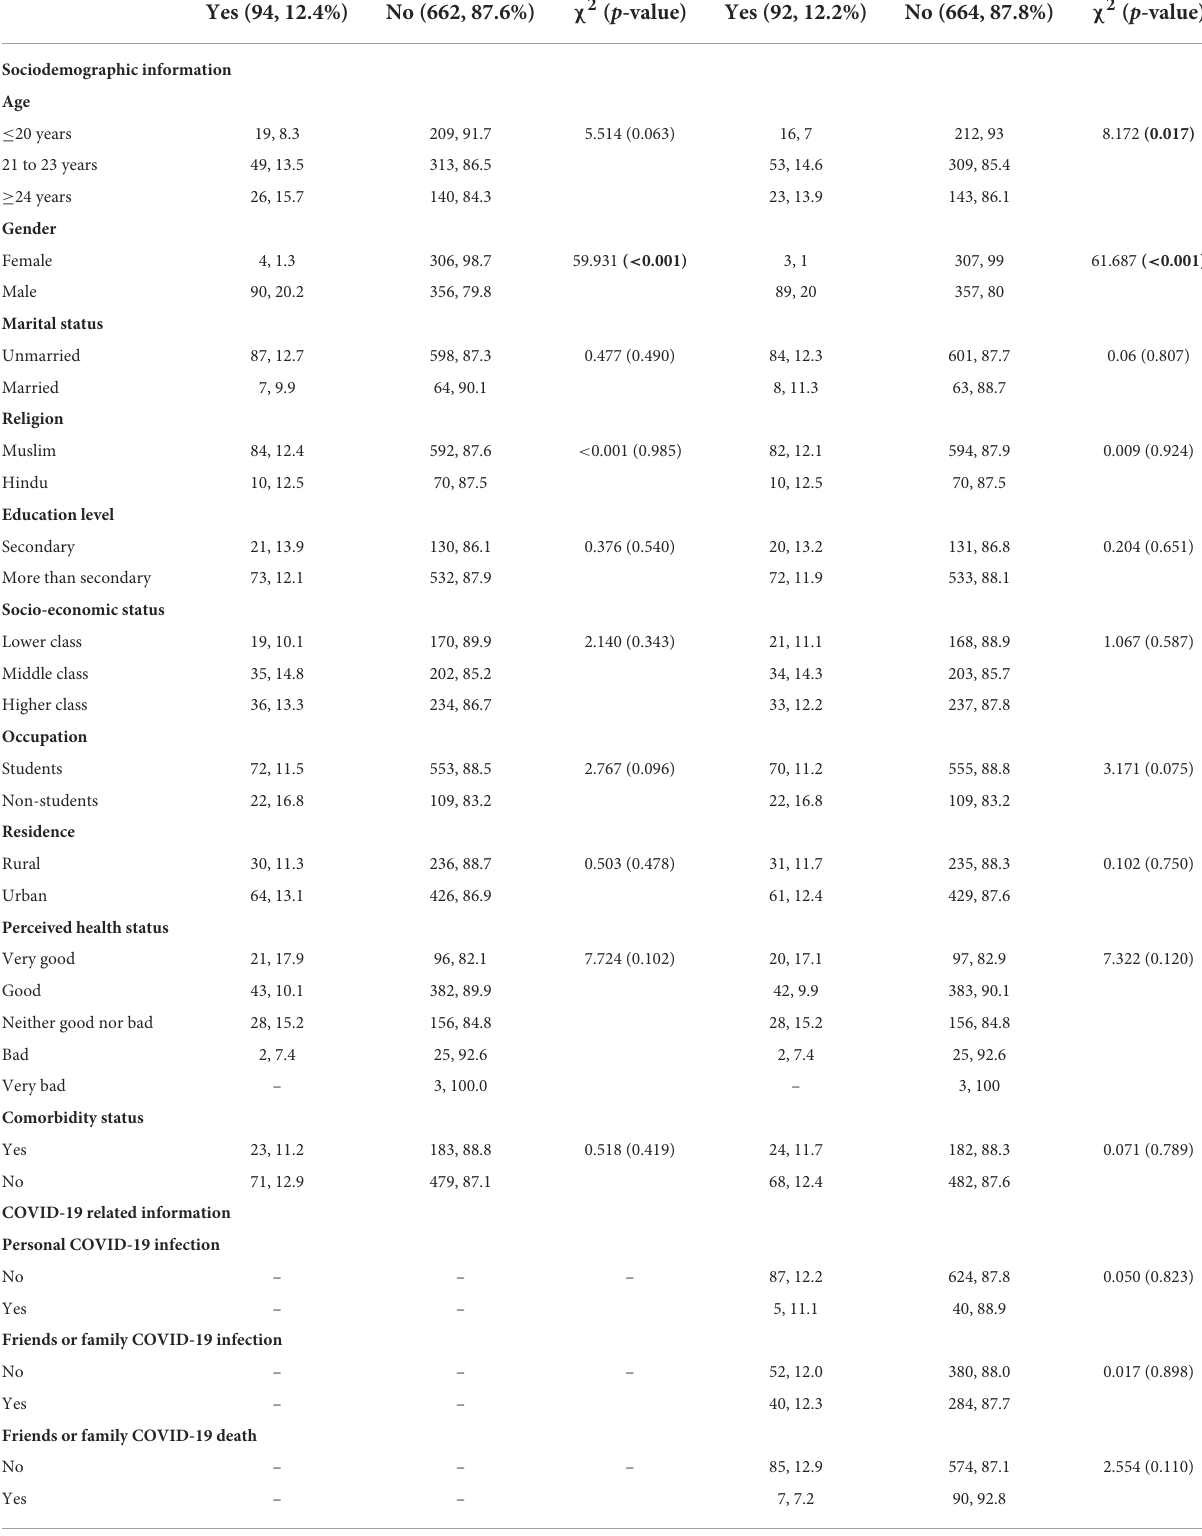
TABLE 2 Associations between the independent variables and smoking.